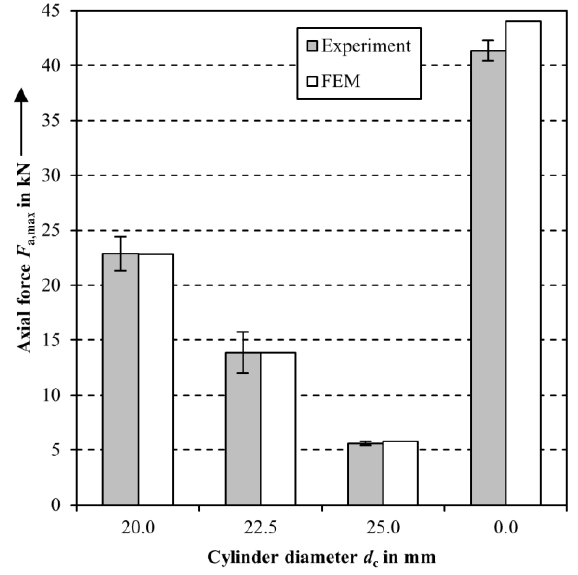
Figure 10. Maximum axial force F a,max and its standard deviation for different cylinder diameters d c for the temperature θ t = 90 °C and θ t = 70 °C for d c = 0.0 mm.